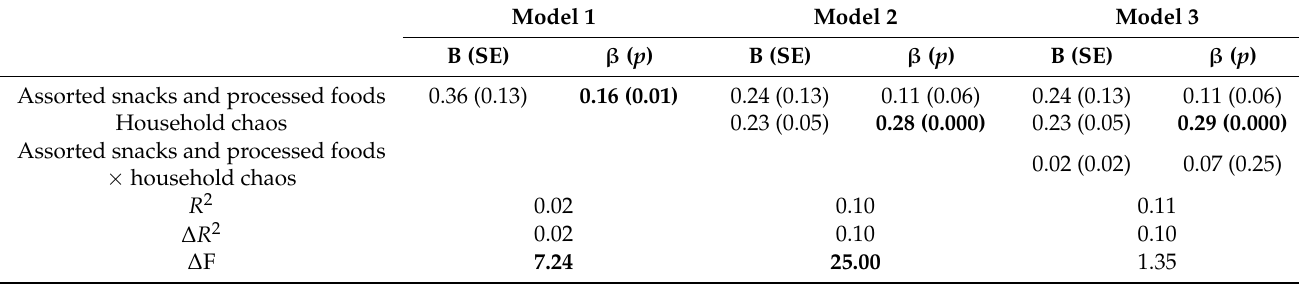
Table 6. Multiple Regression Analyzing Associations Between Assorted Snacks and Processed Foods, Household Chaos, and Flexibility Index